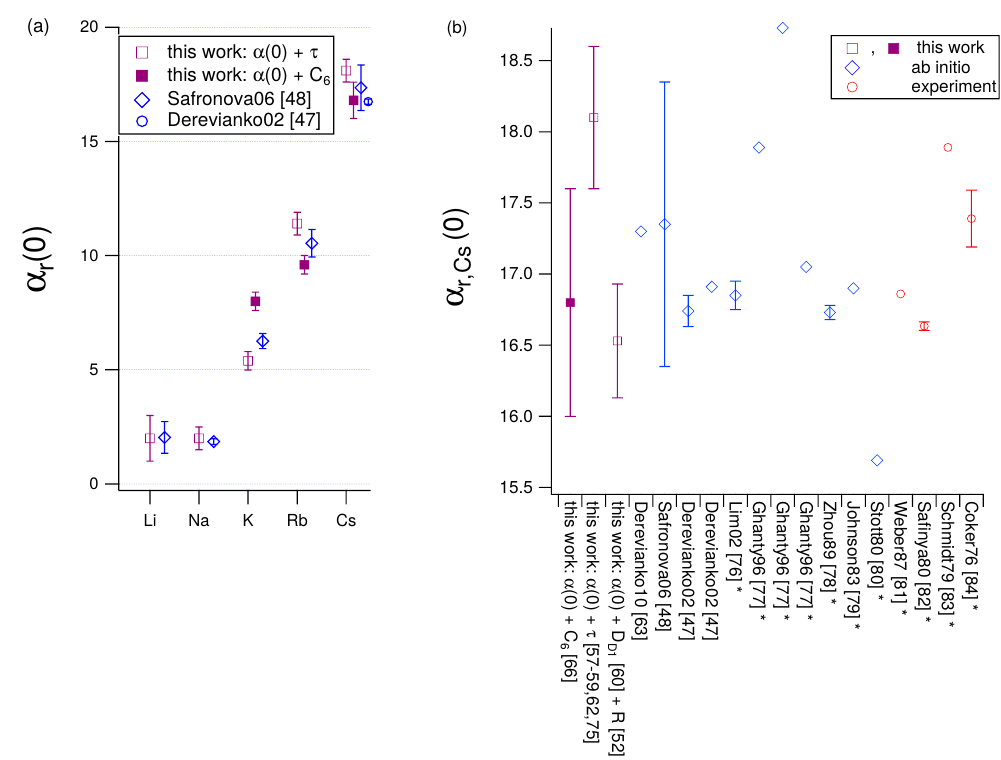
Figure 9. ( a ) α r ( 0 ) values deduced by combining α ( 0 ) measurements [3–5,7,42] with either C 6 measurements [64–66] or principal transition lifetime measurements [50,53–59,62,69–75] and R